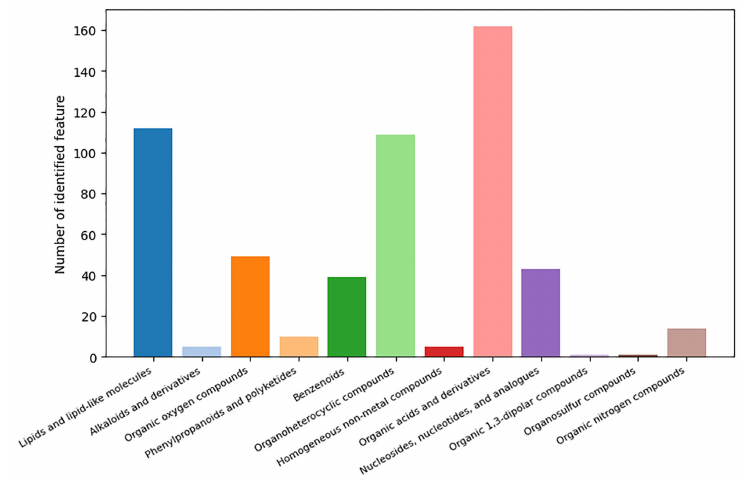
Figure 5. Component analysis of the identified metabolites based on HMDB database.